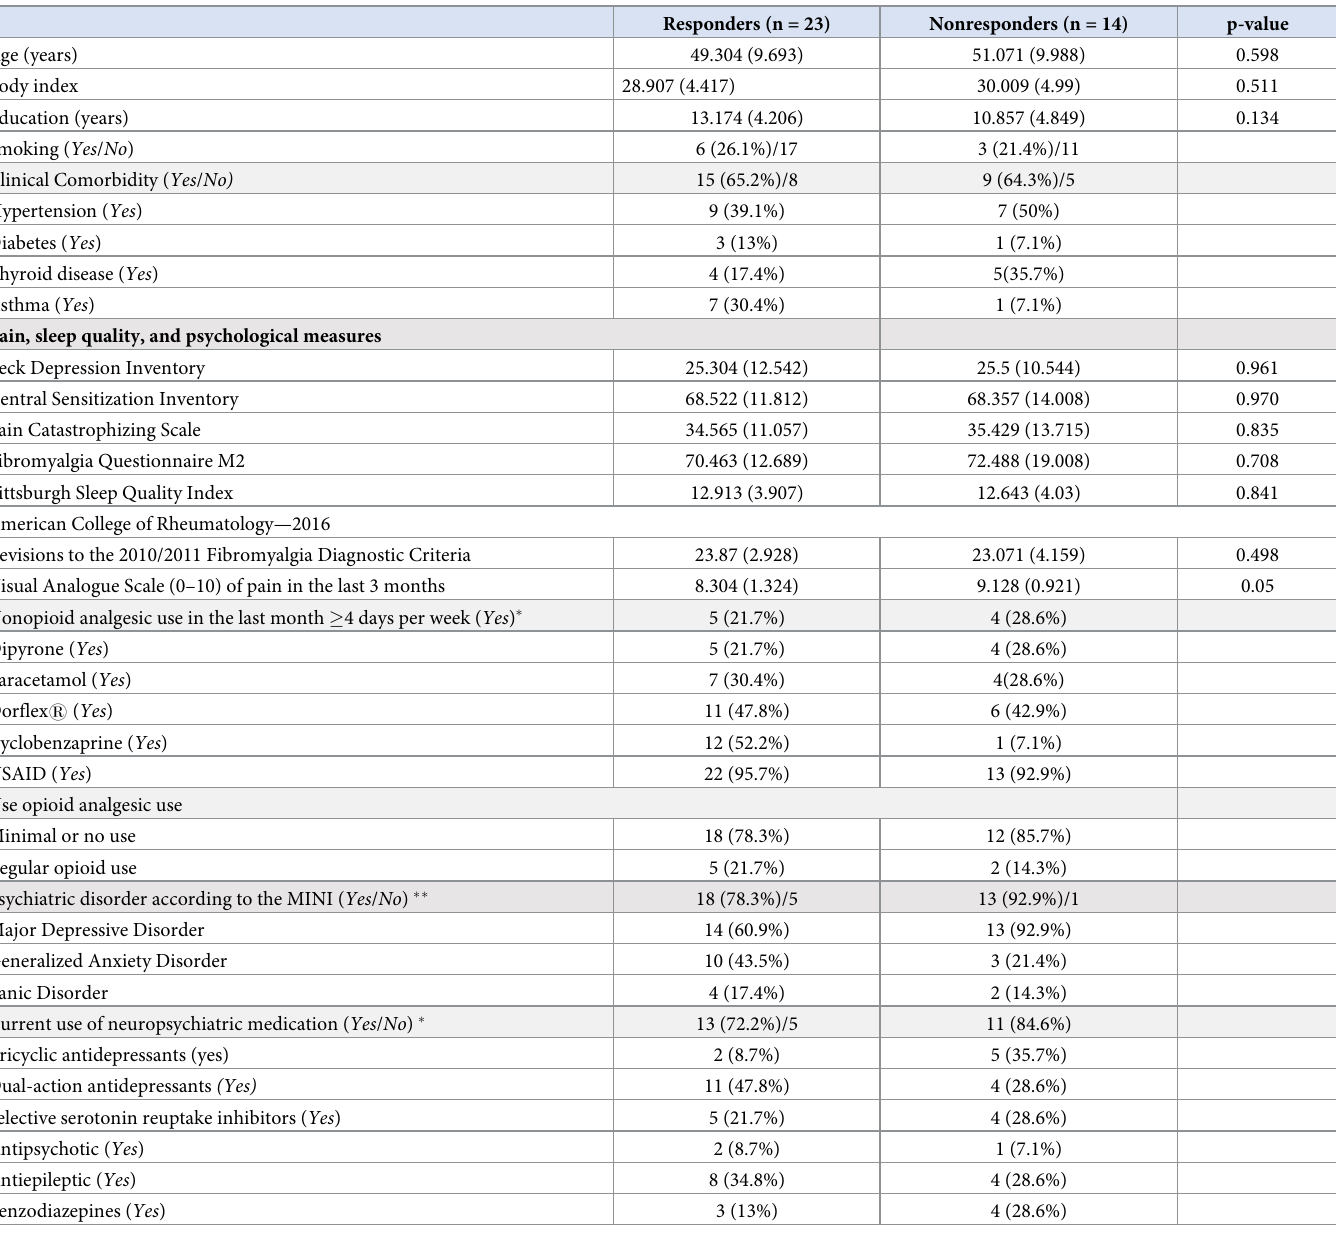
Table 1. Demographic and clinical characteristics of the study sample (n =